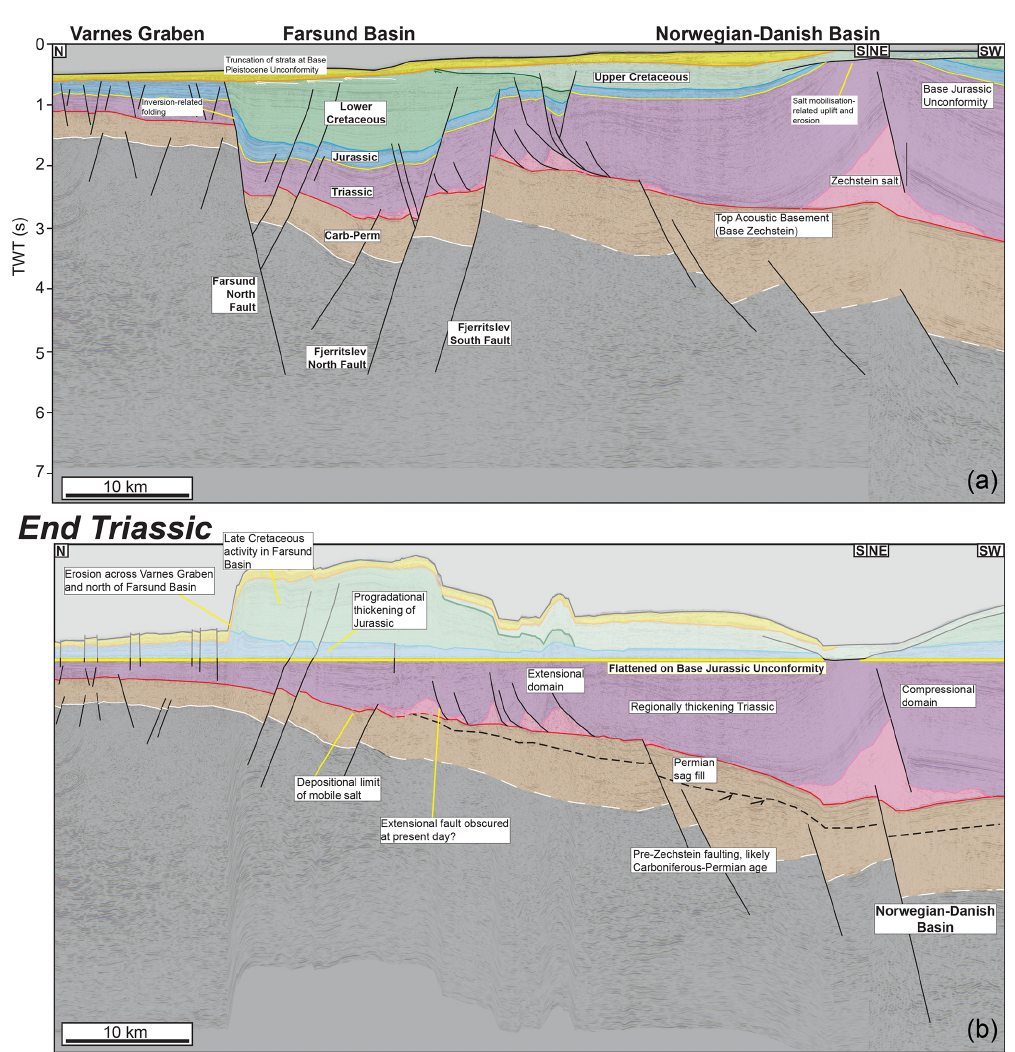
Figure 3. (a) Interpreted N–S oriented seismic section highlighting the present geometry of the Farsund Basin. (b) The same section flattened on the base Jurassic unconformity highlighting the rough structural and stratal geometries present at the beginning of the Jurassic. The Farsund Basin has not formed at this time and is contiguous with the Varnes Graben and Norwegian–Danish Basin to the north and south, respectively. Triassic strata show only regional thinning towards the north, with salt mobilisation occurring down the palaeoslope into the Norwegian–Danish Basin. See Fig. 2 for